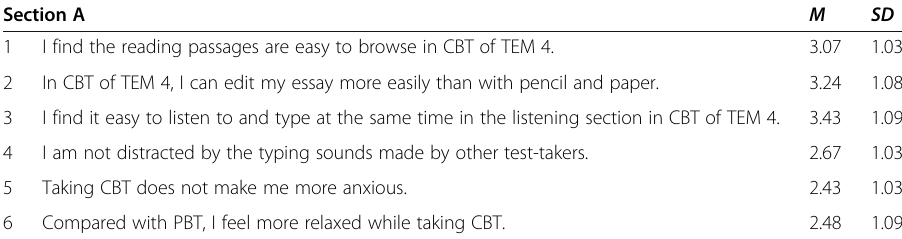
Table 7 Descriptive statistics of items A to F ( N = 46) Section